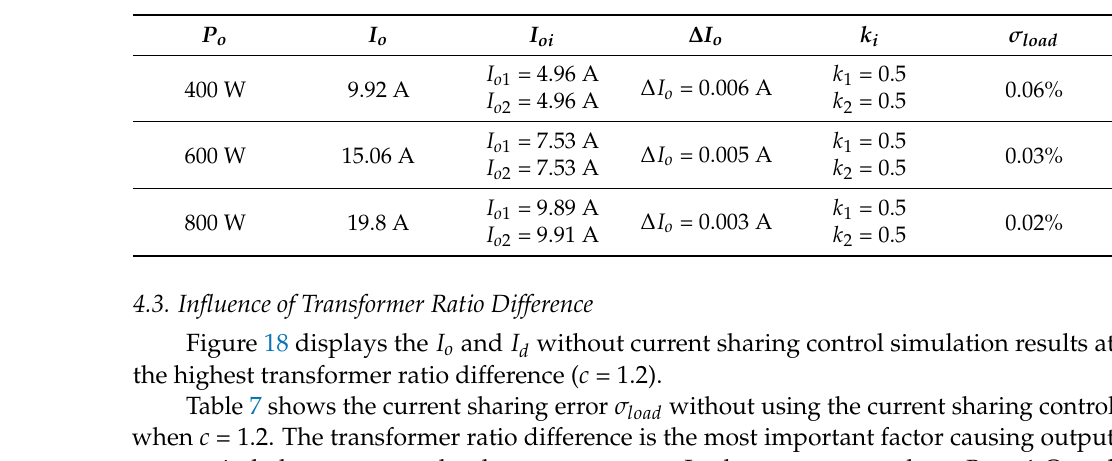
Figure 17. Simulation result of Figure 17. Simulation result of I o and I d in different P o when b = 1.2: ( a ) R o = 4 Ω , P o = 400 W; W; ( b ) ( b ) R o = 2.667 Ω , P o = 600 W; ( c ) R o = 2 Ω , P o = 800 W. Table 6. Data comparison of different output power when b = 1.2.